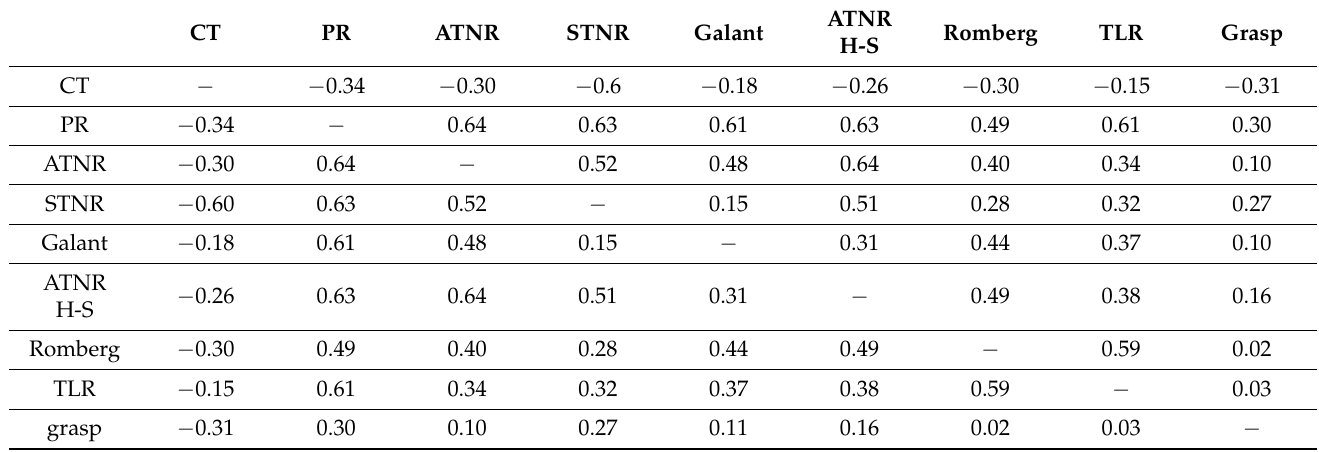
Table 2. The results of correlation analyses performed for clock test and the activity level of